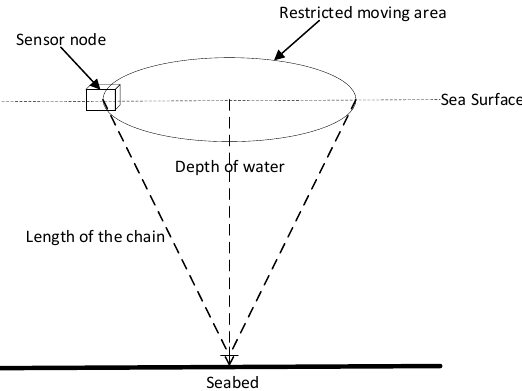
Figure 1. Restricted area for moving sensor nodes.